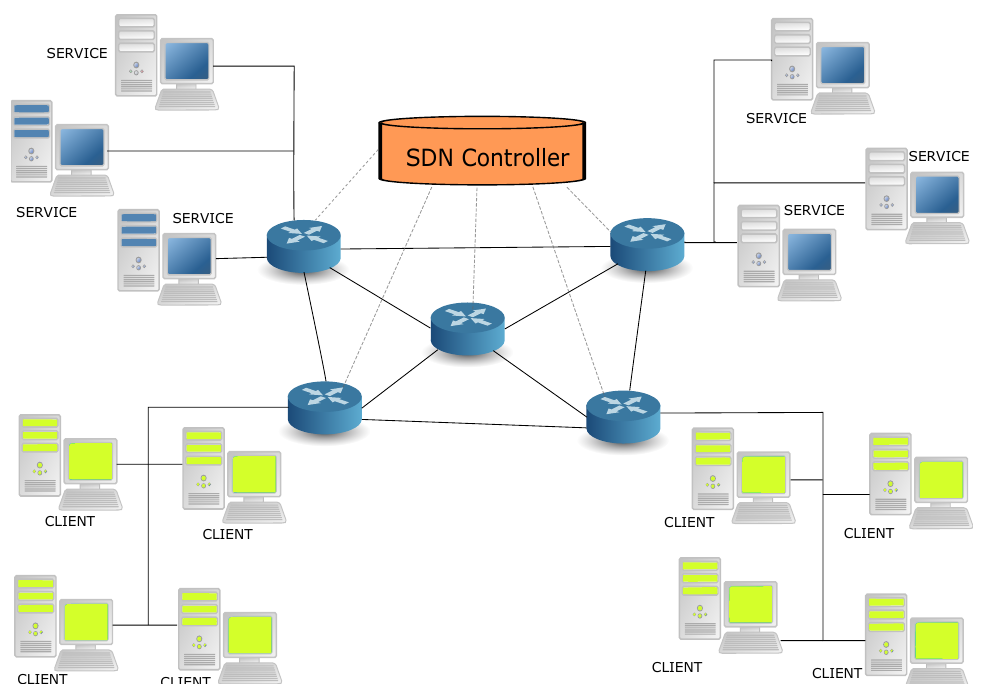
Figure 4. The architecture that we used for the experiments is shown, including the clients and services (resident on servers), plus the SDN network with a SDN controller and 5 SDN switches (the round blue objects) with 8 links between the switches. All the SDN switches are implemented on Intel NUCs. Two switches support the connections to services, while two other switches support the connections to the